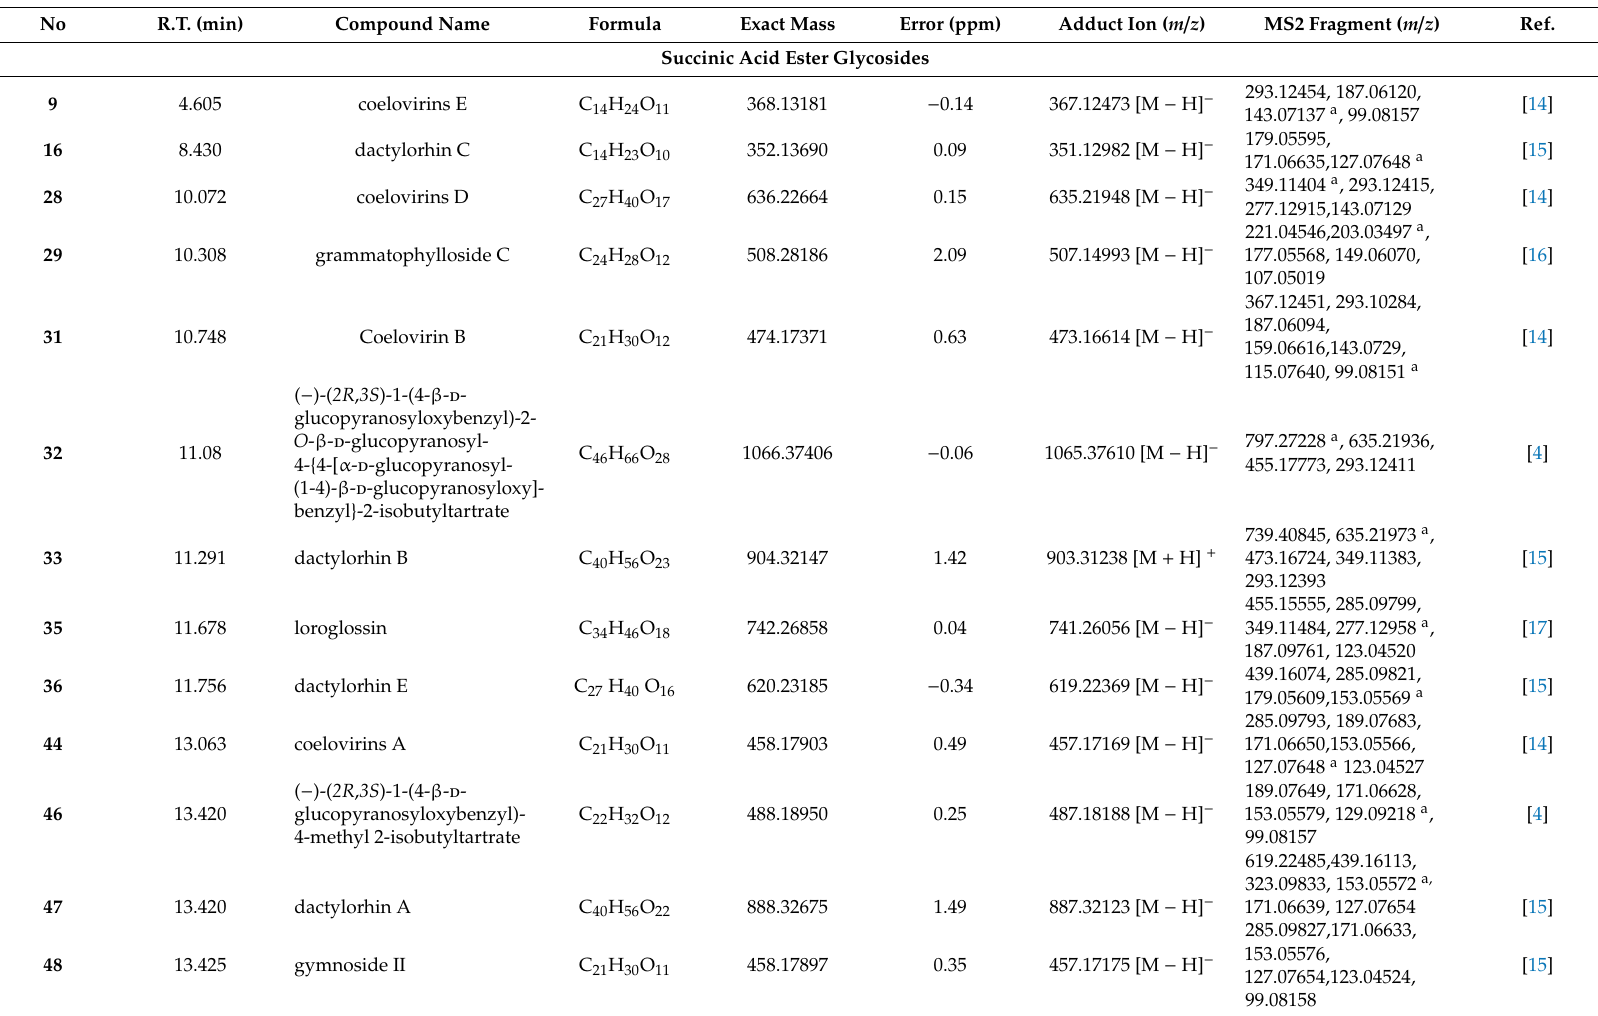
Table 1. All the identified components from G. conopsea extract and their ultra-high performance liquid chromatography mass spectrometer (UPLC–MS / MS)